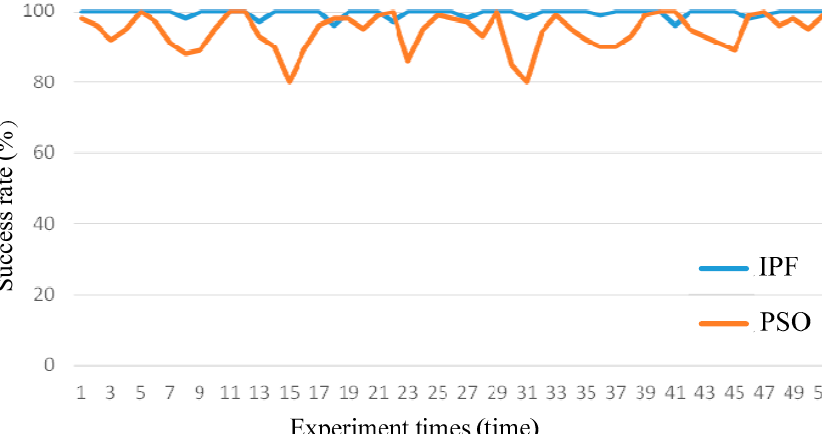
Figure 8. Success rate comparison between IPF and PSO algorithms.